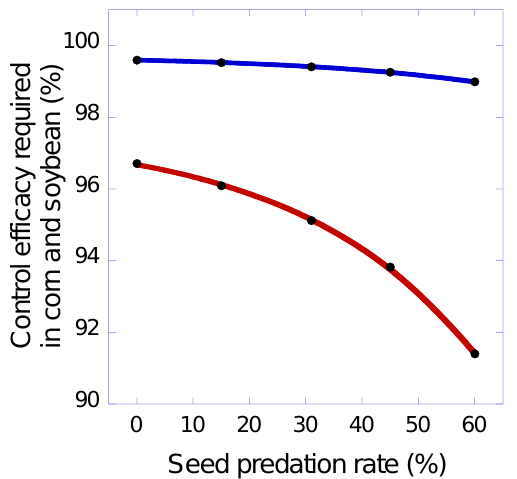
Figure 6. The relationship between seed predation rate and the minimum level of control efficacy required in corn and soybean to prevent increases in giant ragweed seed density in the 2-year (blue line) and 5-year (red line) rotations.